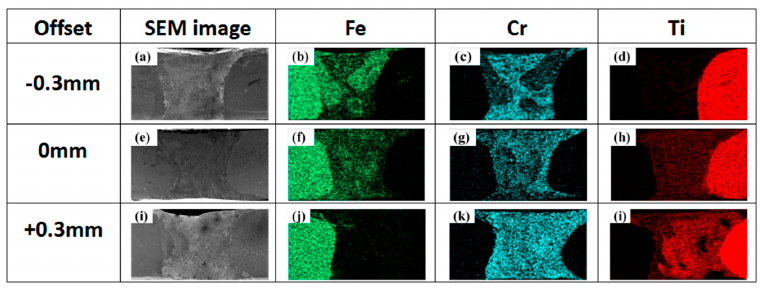
Figure 17. ( a – l ) Map scanning results of elements distribution for 301L / Cu / TA2 welded joints.